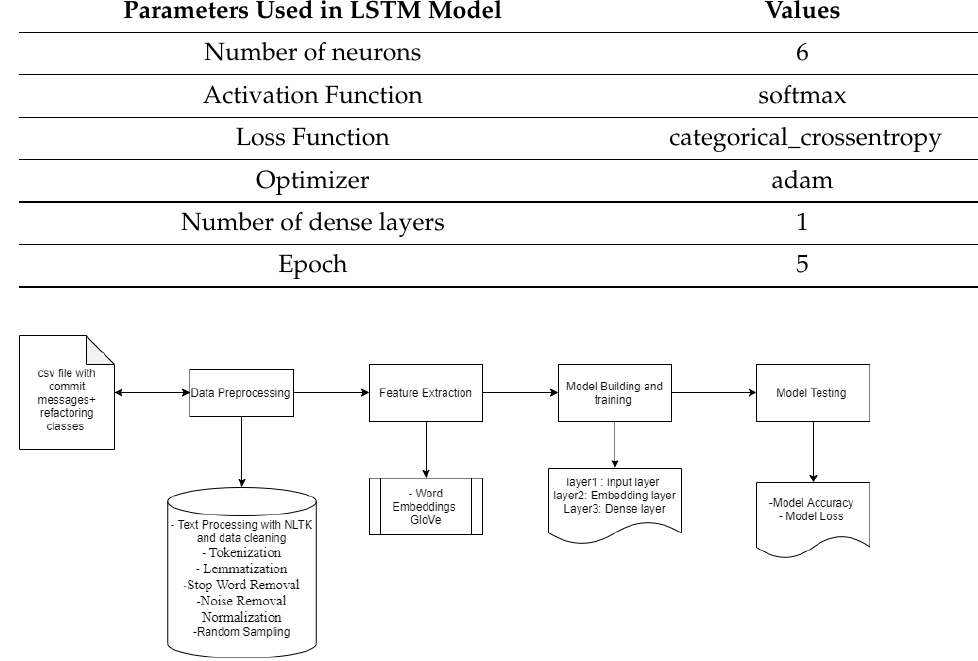
Figure 3. Overview of model with commit messages as